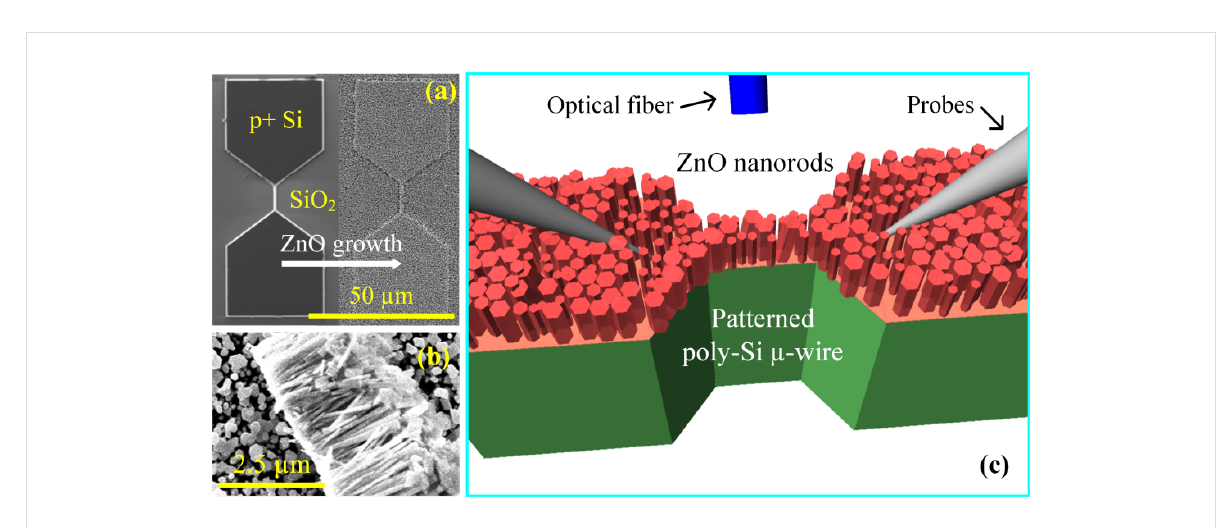
Figure 1: (a) SEM image of the ZnO nanorods grown on ≈ 100 nm thick, highly doped, patterned, p-type, silicon microstructures (before and after ZnO nanorod growth), (b) cross-section SEM image of the ZnO nanorods, and (c) schematic of the electrical probe and optical fiber